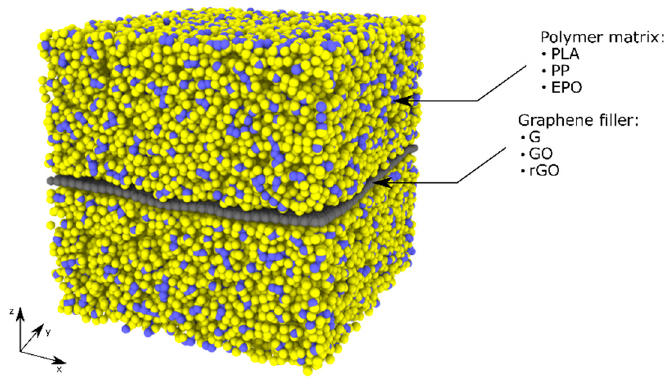
Figure 4. Three-dimensional example of an equilibrated system with PBC and graphene filler that crosses the simulation box (infinite length).